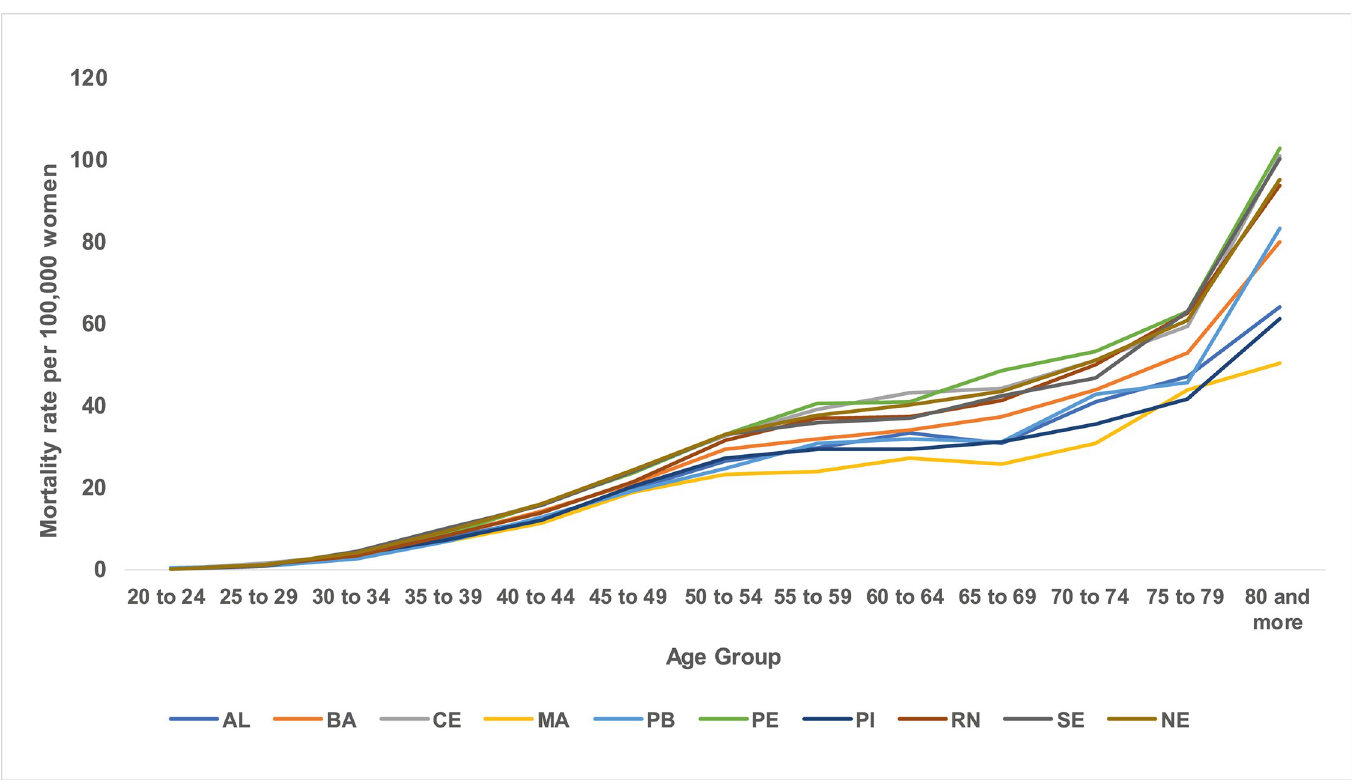
Fig 2. Distribution of mean mortality rates observed for breast cancer according to age groups in Northeast states, Brazil, 1980–2019.